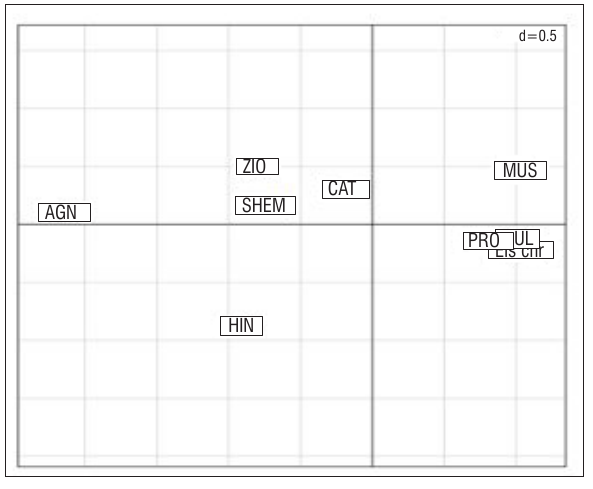
Figure 2: Group centroids characterising the positions of religious affilia- tions along PC1 (horizontal axis) and PC2 (vertical axis).